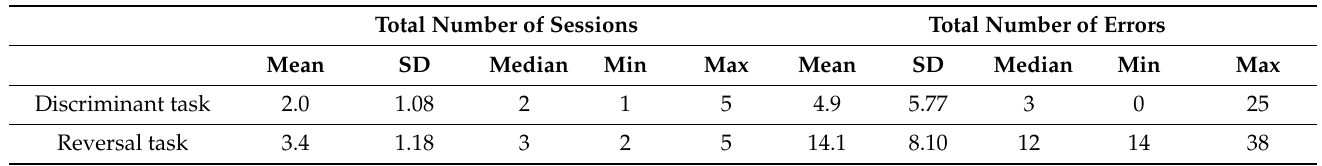
Table 4. Description of the mean, standard deviation, median, minimum and maximum of the Discriminant and Reversal tasks.